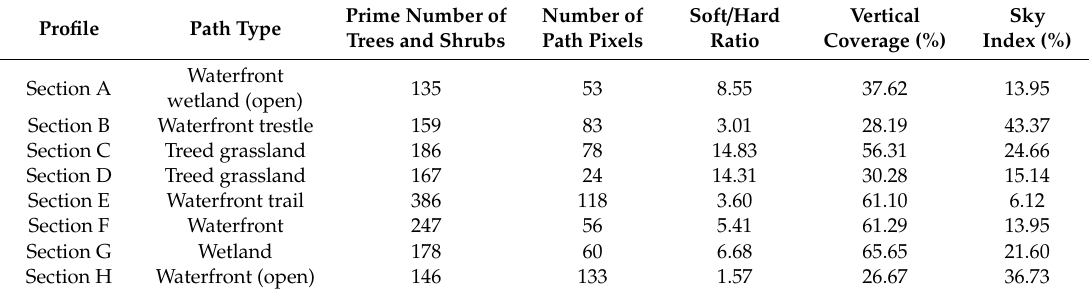
Table 1. Landscape characteristic index statistics of the sample section